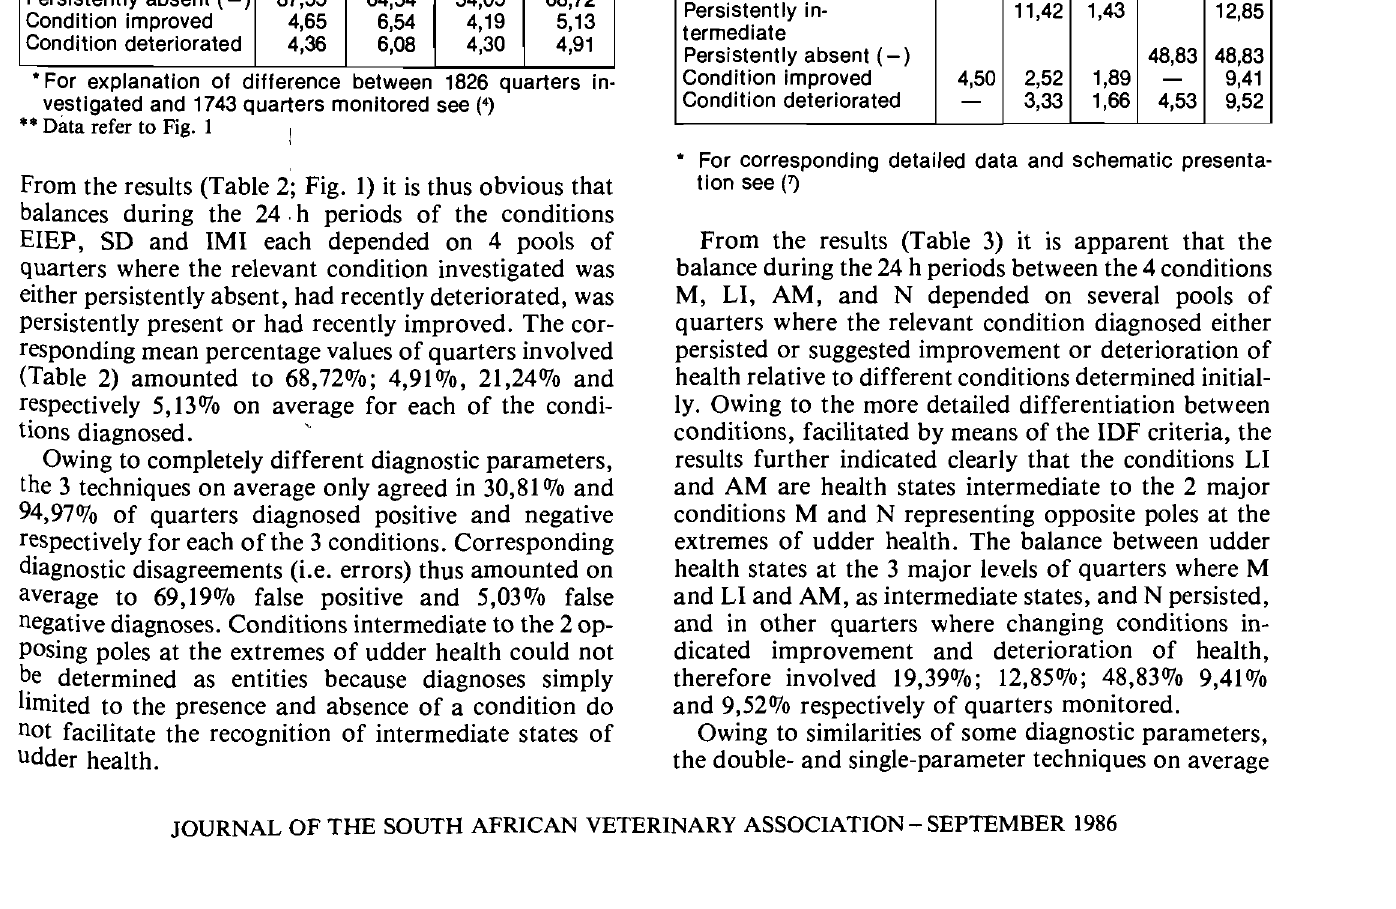
Table 2: Dynamic balance of udder conditions EIEP, SD and IMI each monitored during 24 h periods in 1743* quarters by means of corresponding different single-parameter determinations and expressed as the Table 3: Dynamic balance of 4 udder conditions percentage values of quarters with persisting, monitored during 24 h periods in 1743" quarters by deteriorating and improving conditions * * means of double-parameter determinations in terms of the IDF criteria and expressed as the percentage values of quarters with persisting, deteriorating and Udder conditions determined by means of different techniques x cor improving conditions" Udder conditions determined by means of the same double- General descriptions